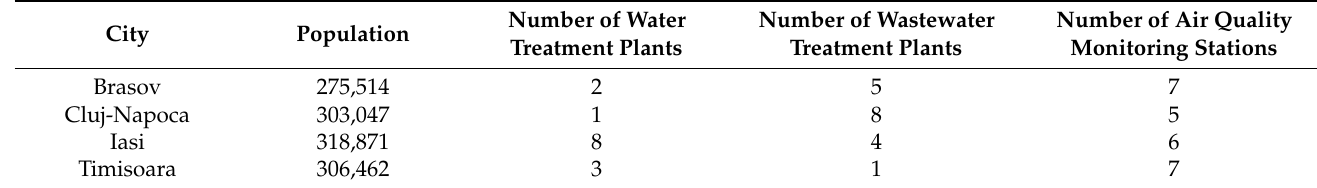
Table 1. Similarities between the evaluated cities